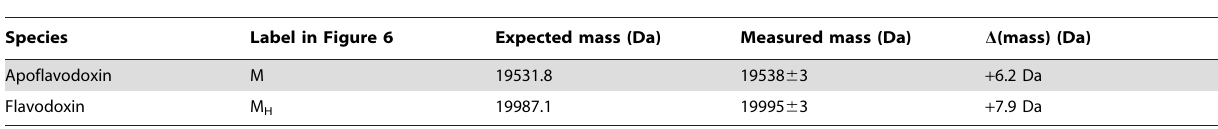
Table 1. Native mass spectrometry of (apo)flavodoxin.